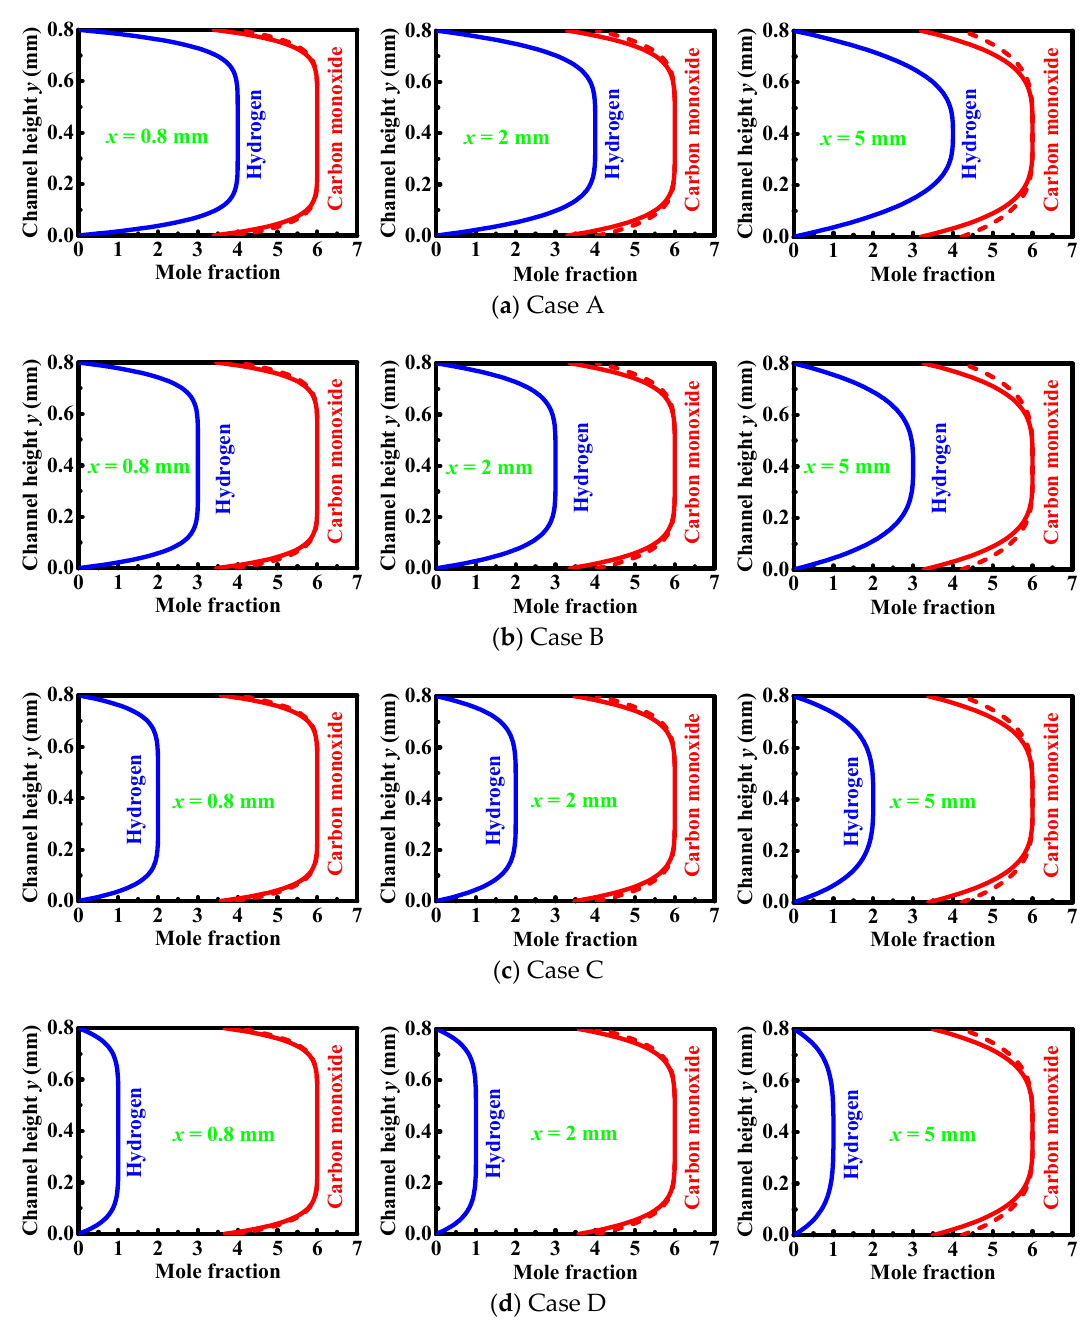
Figure 7. Transverse profiles of carbon monoxide and hydrogen mole fractions for Cases A–D shown in Table 2 at the axial positions indicated. Hereafter, solid-lines and dashed-lines represent the results obtained from the improved mechanism herein and from the mechanism without any hydrogen-involved reactions, respectively.